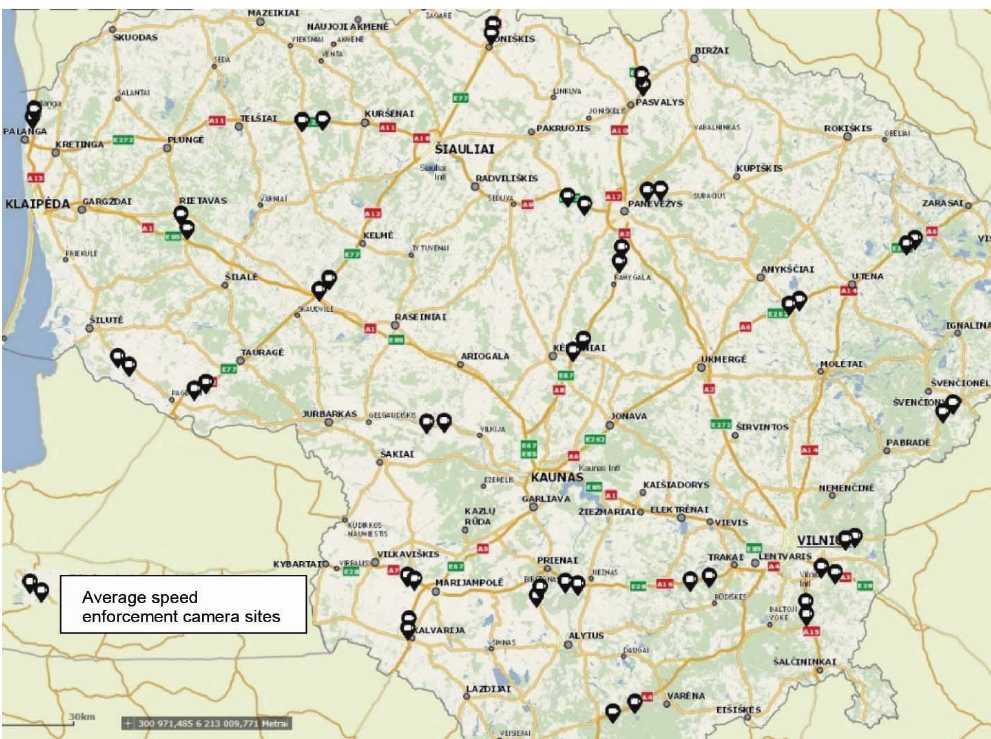
Figure 2. Distribution of the average speed enforcement camera sites on roads of